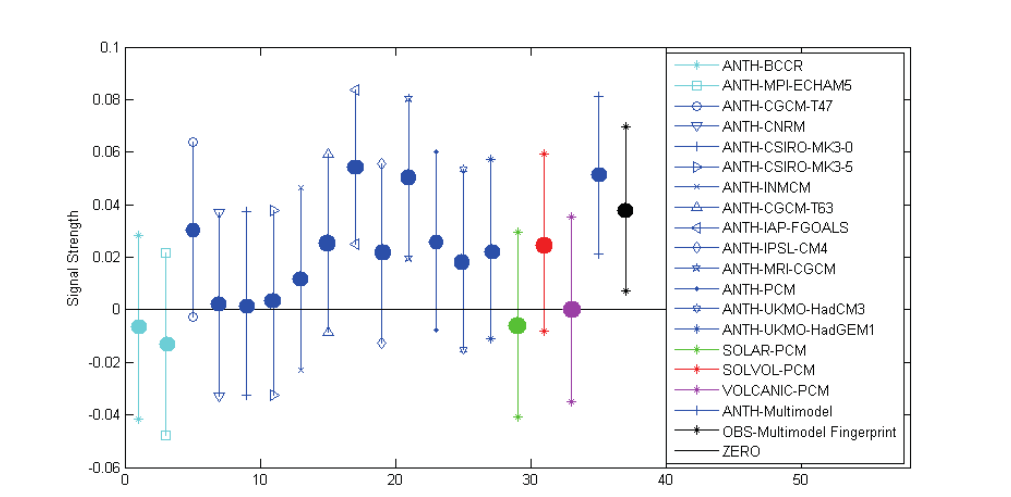
Fig. 5 Detection plot for monsoon streamflow in the Mahanadi River (source: Mondal and Mujumdar 2012). The ensemble-averaged signal strengths (S values) from each model run (dots) and their 95% confidence intervals (bars) are shown. The observed signal strength (S obs ) with its 95% confidence interval, considering the multi-model ensemble-averaged ANTH fingerprint, is shown in black. The GCMs for which the ANTH signal strength is inconsistent in sign with S obs are marked in cyan and those for which the ANTH signal strength is consistent with S obs are marked in